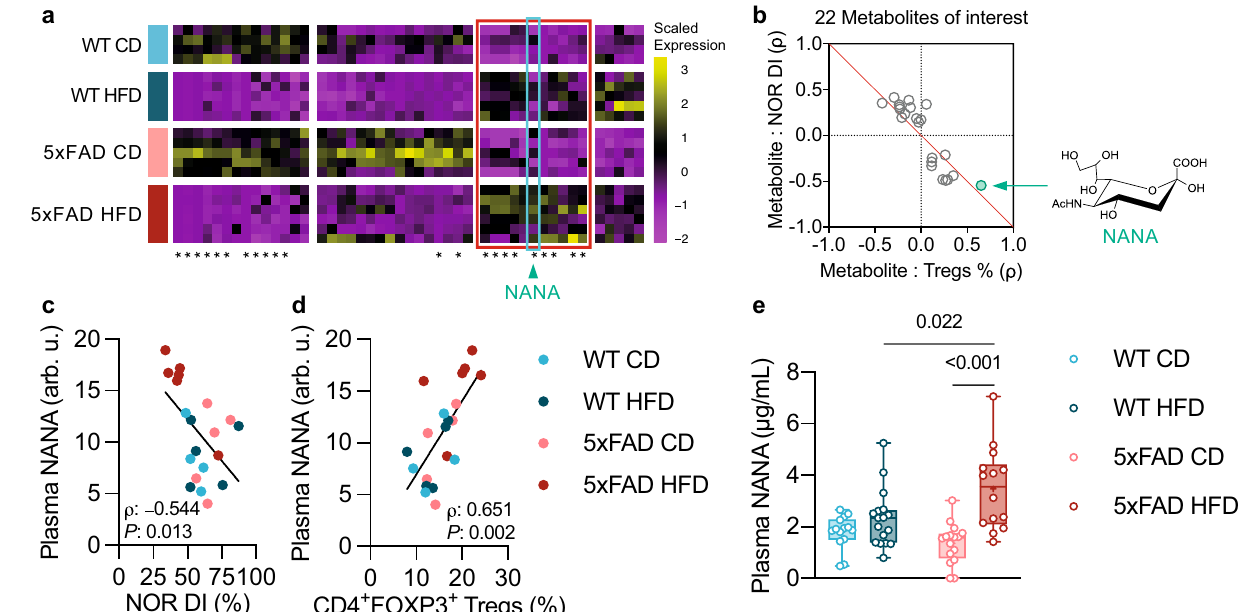
Fig. 4| HighplasmalevelsoffreeNANA inHFD-fed5xFAD mice.a – d Metabolite pro fi ling of plasma samples collected from some of the male mice that were eval- uated for both cognition (NOR test; Fig. 1c) and systemic immune phenotype (Fig. 3a – c), sample n : WT CD=4, WT HFD=5, 5xFAD CD=5, 5xFAD HFD=6. a Heatmap representation of the plasma metabolites whose linear regression modelshadunadjustedone-way omnibus ANOVAtest P -value<0.050(46outof229 totalidenti fi edmetabolites).Eachcolumnrepresentsonemetaboliteandeachrow one sample (mouse). Asterisks indicate the metabolites of interest (22 in total; Methods). The red box highlights the block of metabolites whose overall levels trended highest in HFD-fed 5xFAD mice, which include N -acetylneuraminic acid (NANA; cyan box and green arrowhead). Complete list of identi fi ed metabolites, regression coef fi cients, and exact P -values is provided in Supplementary Data 3, “ cell means model ” tab. b , ρ - ρ plot (Methods). The red diagonal discriminates between metabolites associated with high NOR discrimination index (DI) and low